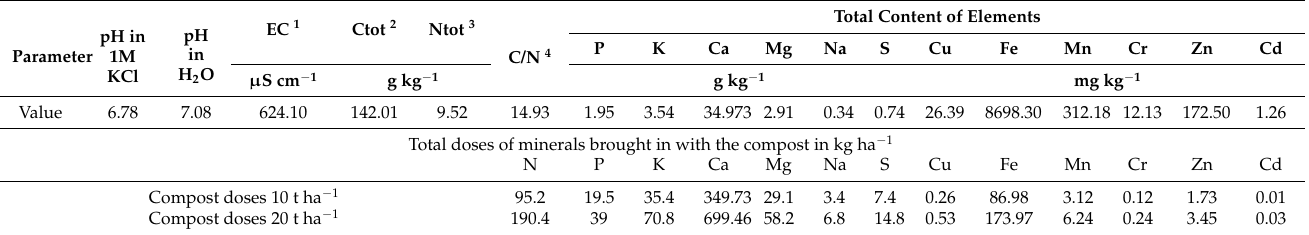
Table 1. Physicochemical properties of the compost used in this study and total doses of minerals brought in with compost